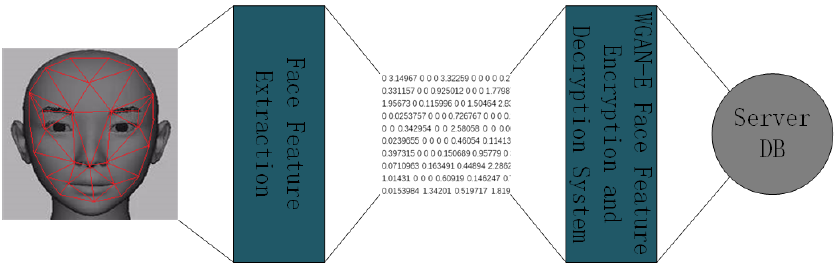
Figure 6. WGAN-E face feature encryption and decryption system. Note: DB is database. A facial feature is generated by LBP feature extraction to generate a series of codes for representing feature values. These face feature codes are stored in the server after being encrypted by WGAN-E face features. When face information needs to be identified, the facial features are extracted from the server and the original facial features can be obtained by WGAN-E decryption.